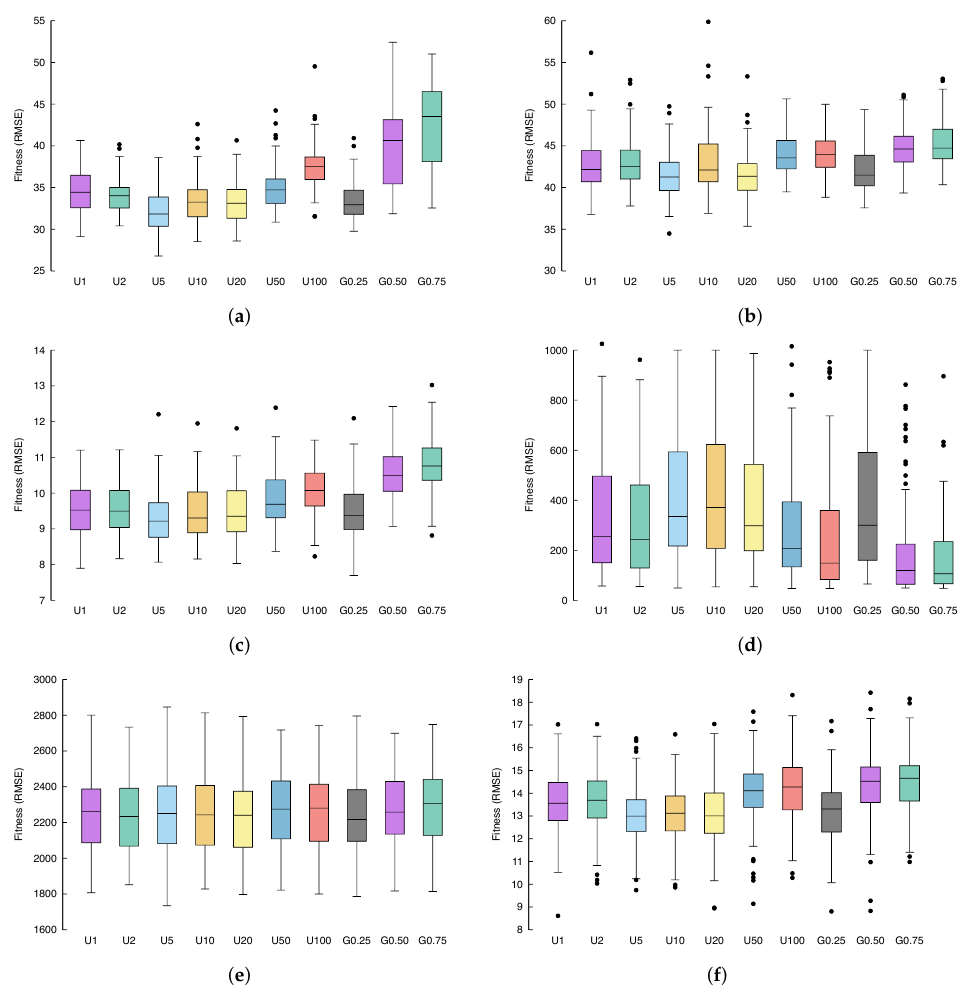
Figure 4. Box-plots of the RMSE on the test set over 100 independent runs of the considered benchmark dataset for all the proposed methods. ( a ) Air; ( b ) %F; ( c ) conc; ( d ) %PPB; ( e ) LD50; ( f ) yac. Table 3. Fitness values obtained by selecting the ancestors with uniform multi-generational selection. The values in bold are the best results